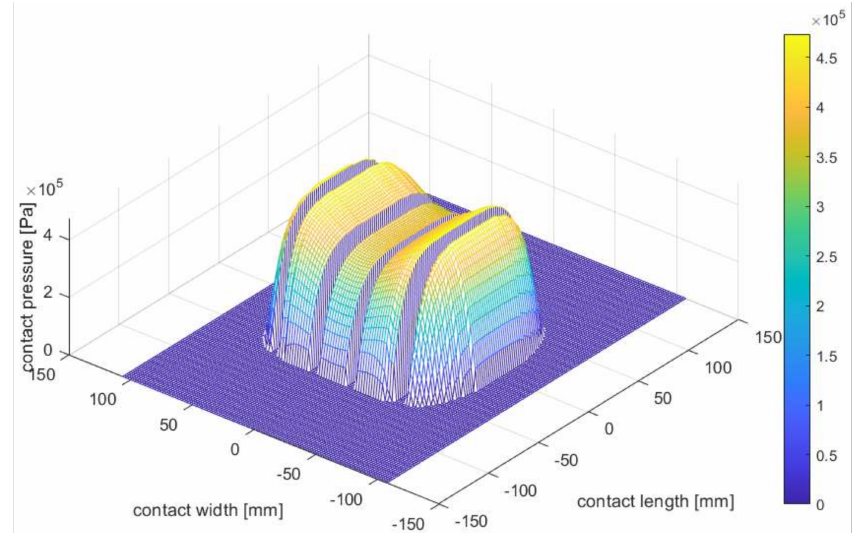
Figure 3. The contact patch model results.